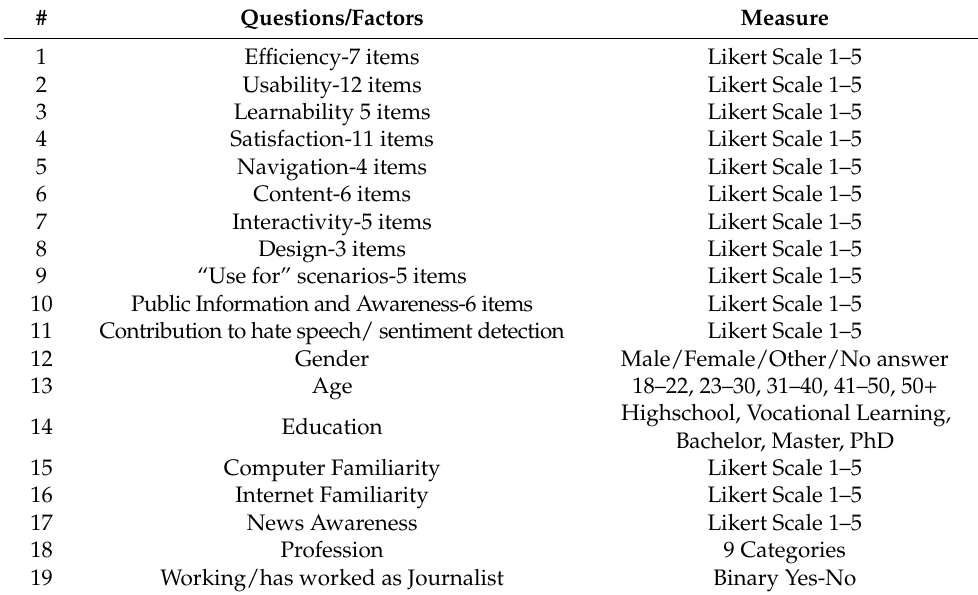
Table 3. Overview of the formulated